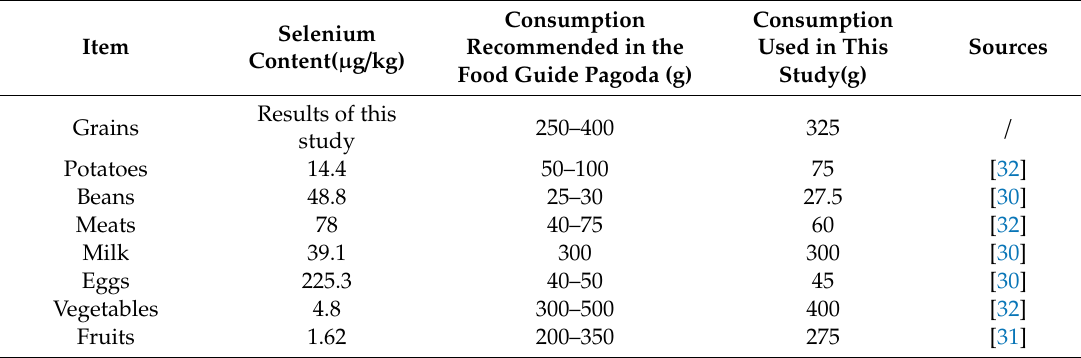
Table 2. Selenium content and consumption